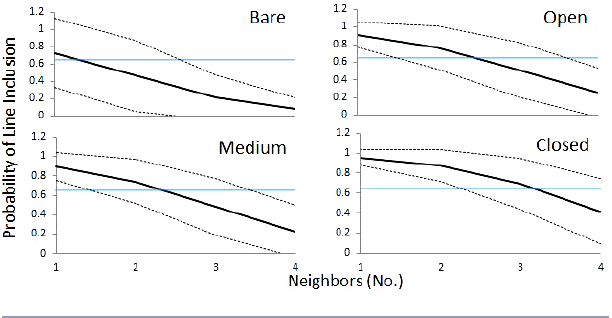
Table 3 . Parameter estimates and odds ratios for variables in